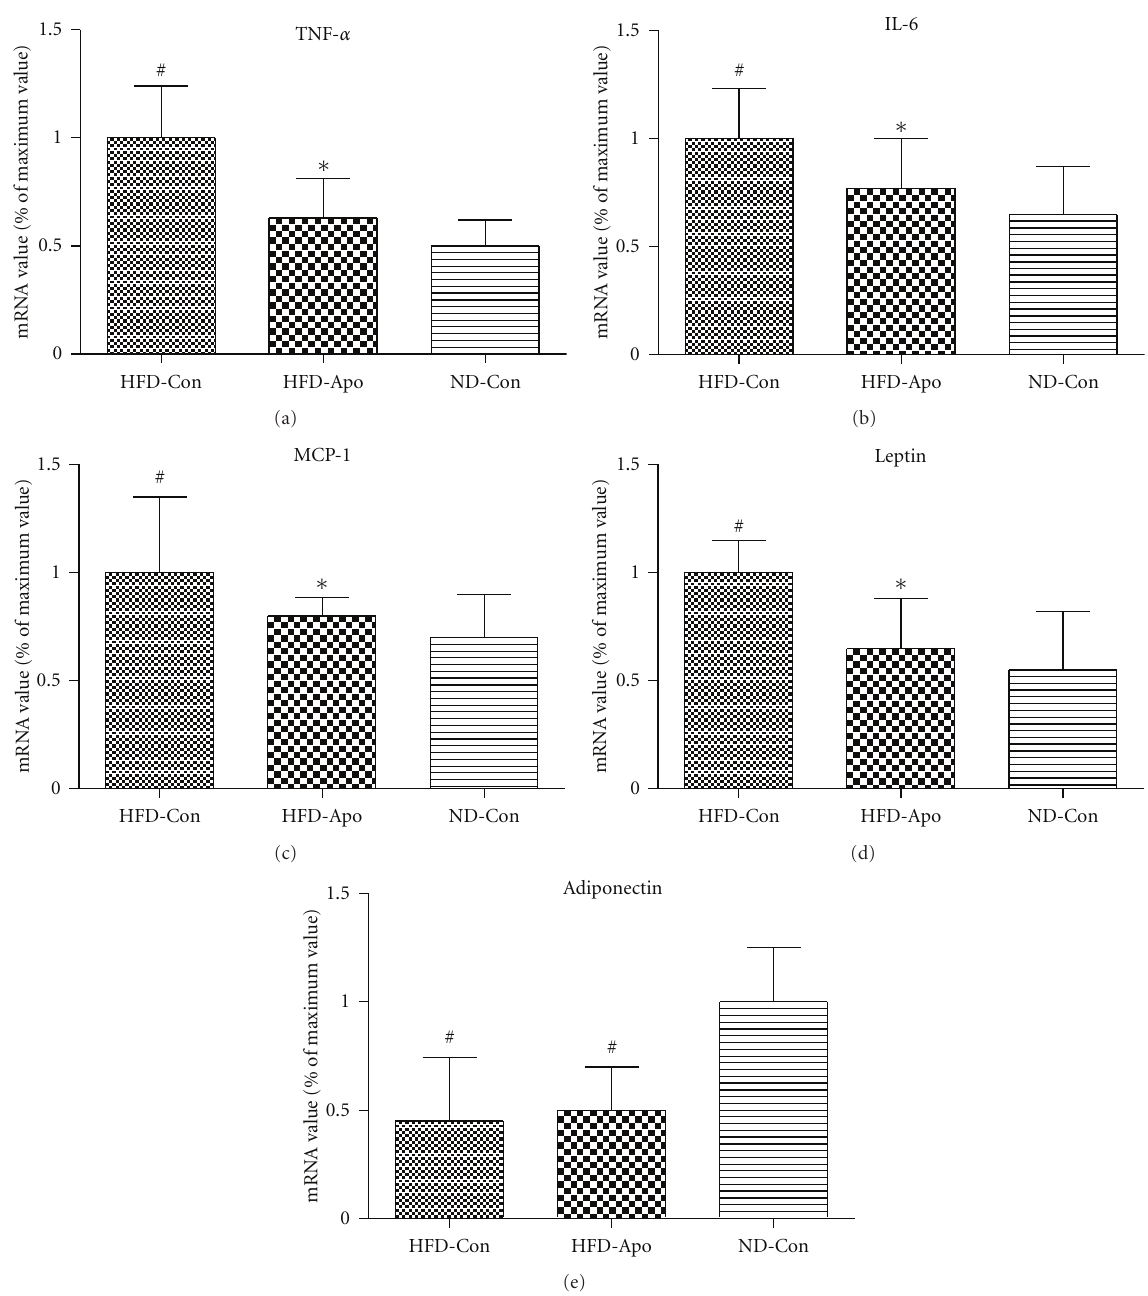
Figure 4: E ff ects of apocynin on inflammation-related genes expression in adipose tissue. The levels of mRNA expression of TNF- α , IL-6, MCP-1, leptin, and adiponectin in the epididymal adipose tissue were determined by quantitative PCR. (a) TNF- α , (b) IL-6, (c) MCP-1, (d) Leptin, and (e) Adiponectin. Apocynin decreased the gene expression of TNF- α , IL-6, MCP-1, and leptin in HFD-Apo compared to the HFD-Con group. The gene expression of adiponectin did not change among three groups. # P < . 05 versus ND-Con group, ∗ P < . 05 versus HFD-Con